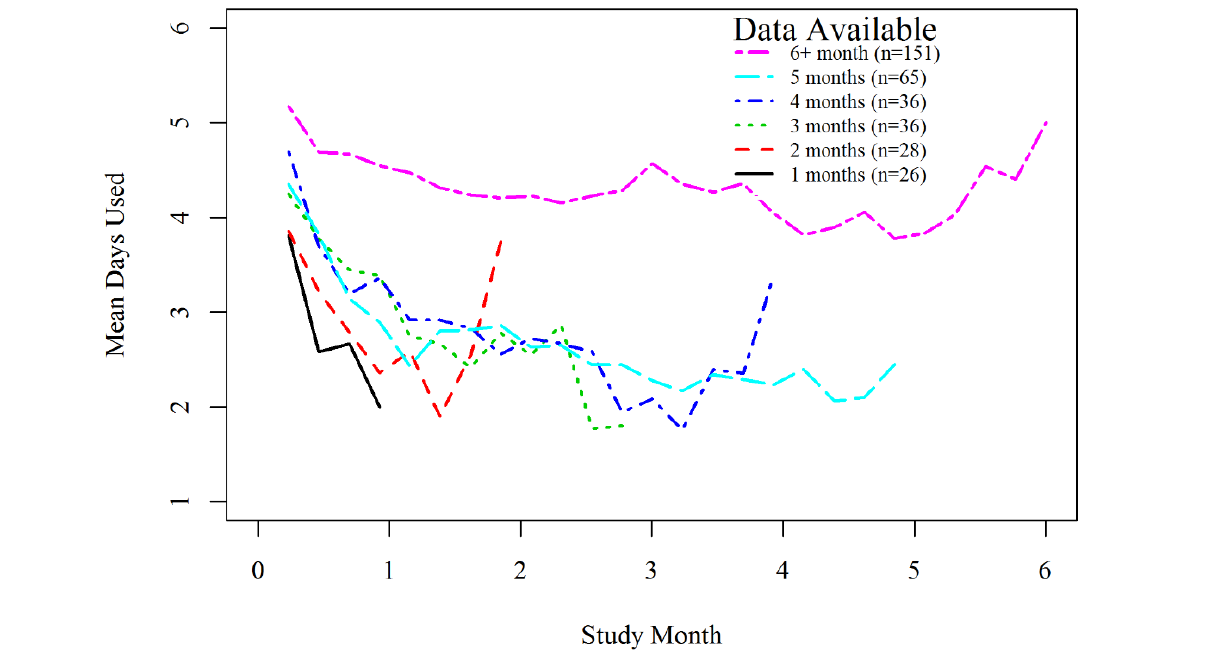
Figure 2. Mean engagement with mHealth intervention (intervention use) over the course of the study for groups of participants categorized by duration of mobile data